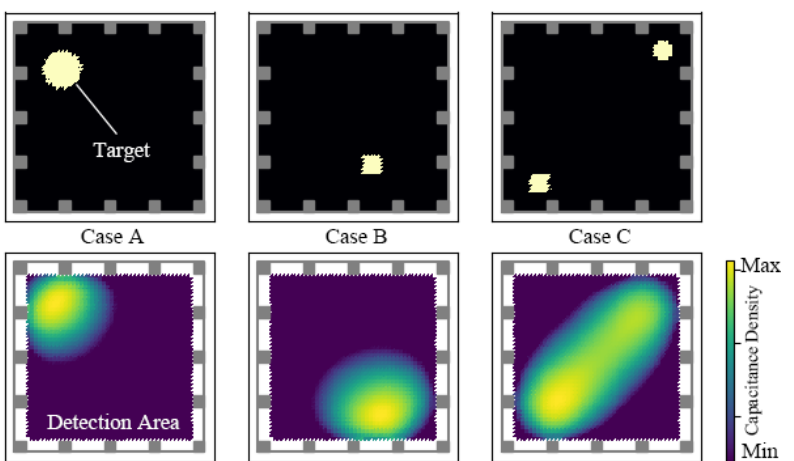
Figure 5. Reconstruction results of the algorithm. The first and second rows represent the ground truth and the reconstruction result, respectively. Inside ground truth image, the black area possesses a capacitance density of zero, while the yellow area is the ground truth target whose value is 1 × 10 − 9 F/m 2